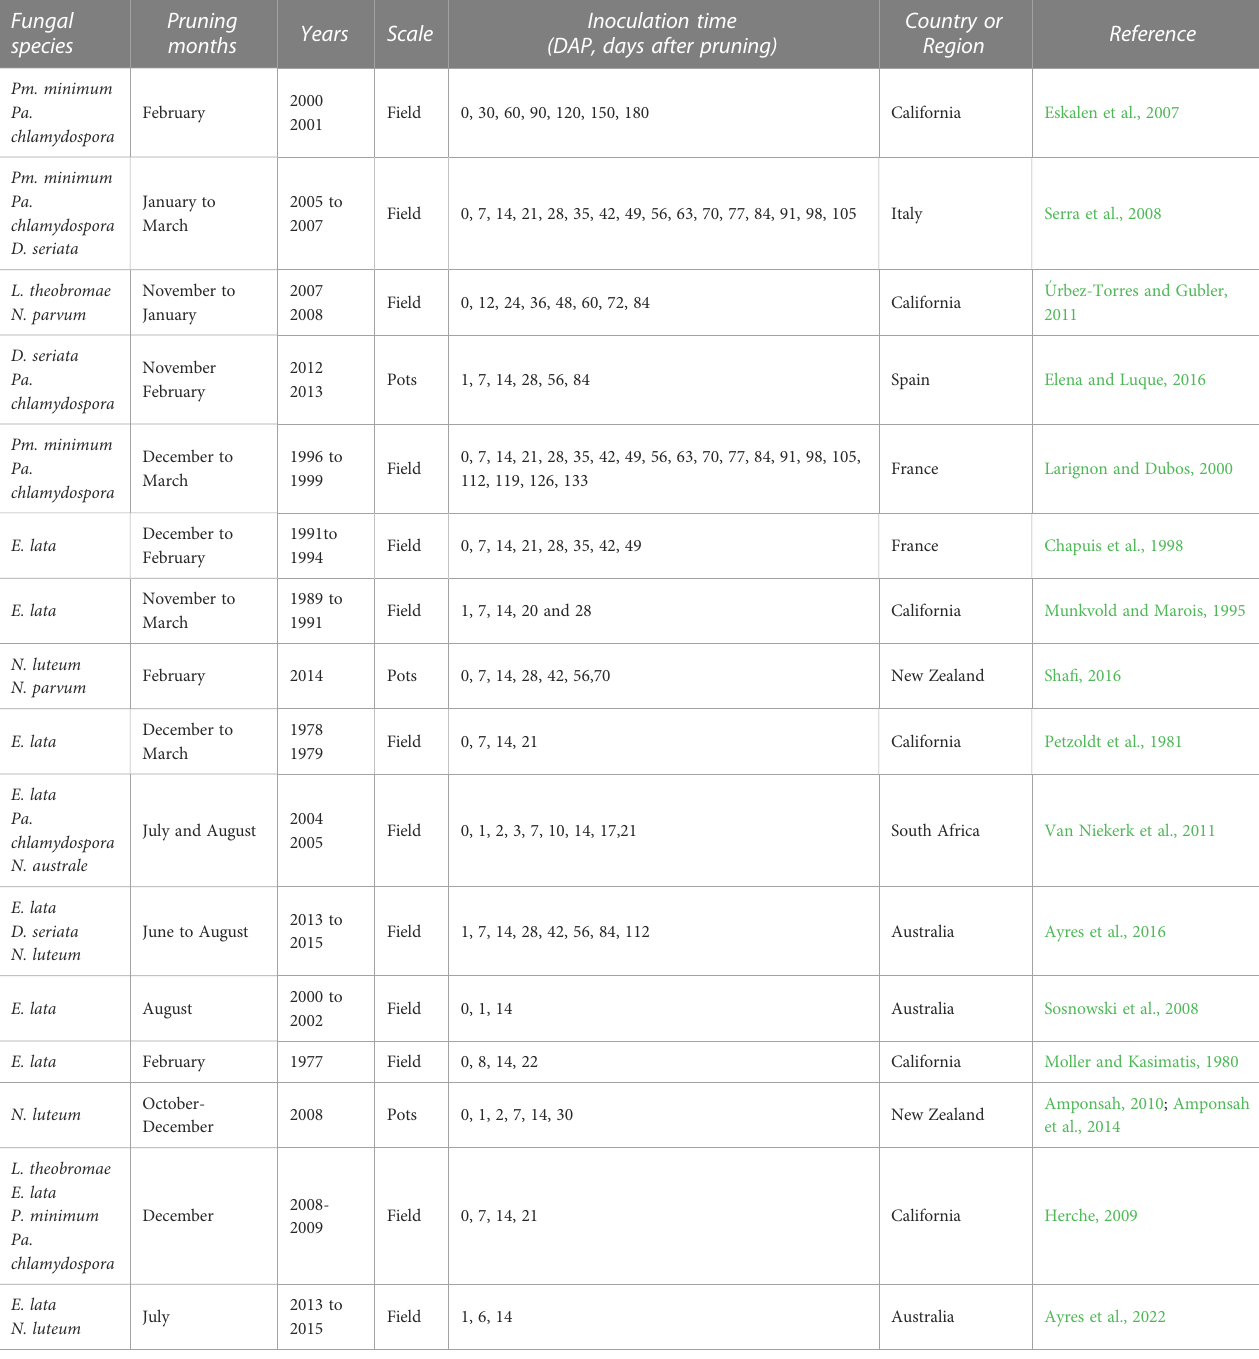
P< 0.001 (Table 2 and Figure 6). For Botryosphaeria dieback, a signi fi cant interaction between pruning period x GTD (Table 3) showed that the susceptibility decreased faster for late pruning ( a =0.024) and early pruning ( a = 0.019), which were not signi fi cantly different from each other ( P = 0.999), than for mid- pruning ( a = 0.010; P = 0.021 and 0.029, respectively) (Supplementary Material S2). Wound susceptibility decreased faster when pruning wounds were inoculated with E. lata ( a = 0.049) than with other fungal species ( a ranged from a minimum of 0.011 for D. seriata to a maximum of 0.023 for N. parvum , Table 2; with P< 0.001,